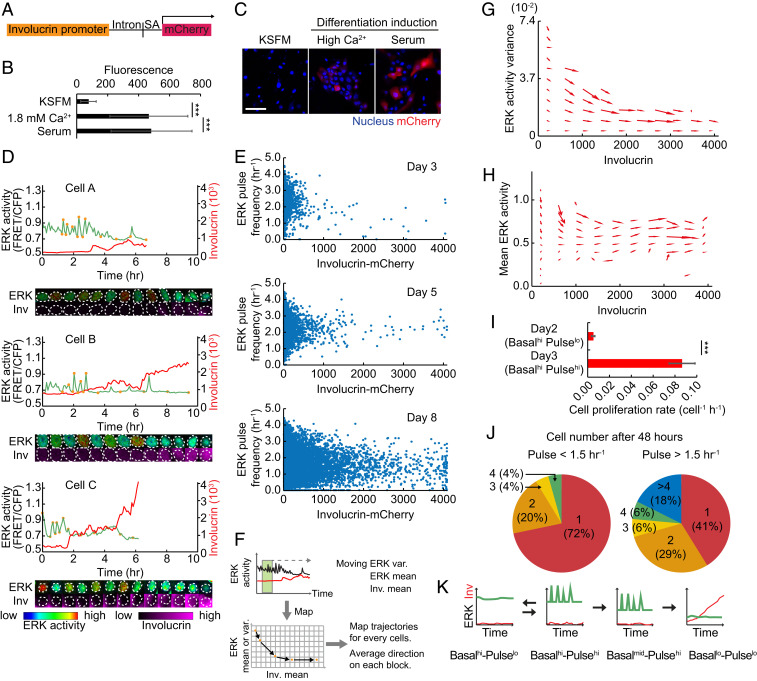
ERK pulse down-regulation precedes commitment to differentiation. (A) Construction of Involucrin-mCherry reporter. SA, SV40 splice acceptor. (B and C) Involucrin-mCherry reporter expression in cells cultured under the indicated conditions. Data are mean ± SD (n = 50 cells each). (Scale bar: 100 μm.) (D) Representative time series of ERK activity (green) and Involucrin-mCherry expression (red), and images of the cells at the time points indicated by the orange circles in each time series. Images are shown by the indicated lookup tables below. (E) Dot plots of ERK pulse frequency and Involucrin-mCherry expression in HNK cells on different days (n = 3,323 cells for day 3, 11,527 cells for day 5, and 37,320 cells for day 8 cells). (F) Schematics of the methodology for constructing the phase diagram of ERK activity. ERK moving variance and ERK and Involucrin moving mean levels are measured for each cell. Mapping of each ERK measure in relation to Involucrin generates a trajectory of the coevolution of the two factors. (G and H) Phase diagram of ERK (G) activity variance and (H) mean activity against mean Involucrin expression obtained from n = 3,397 cells. Arrows indicate the direction of transition for each compartment. (I) The proliferation rate of NHK cells in the ERK Basalhi-Pulselo state (day 2) and Basalhi-Pulsehi state (day 3). Cell divisions were counted in time series images, and the increase in cell number was divided by the imaging period. Data are mean ± SD (n = 542 cells for day 2 and 3,323 cells for day 3). (J) Cell proliferation assay of single cells with ERK pulses lower (Left) or higher (Right) than 1.5 pulses per hour. Single cells were initially imaged to measure their pulse levels, and then the same cells were observed after 48 h. The number of daughter cells at 48 h and their respective fractions are indicated. (K) Schematic representation of modulation in ERK activation pulses during differentiation. Statistical significance was examined by two-tailed unpaired Student’s t test; P values are indicated by ***P < 0.001.